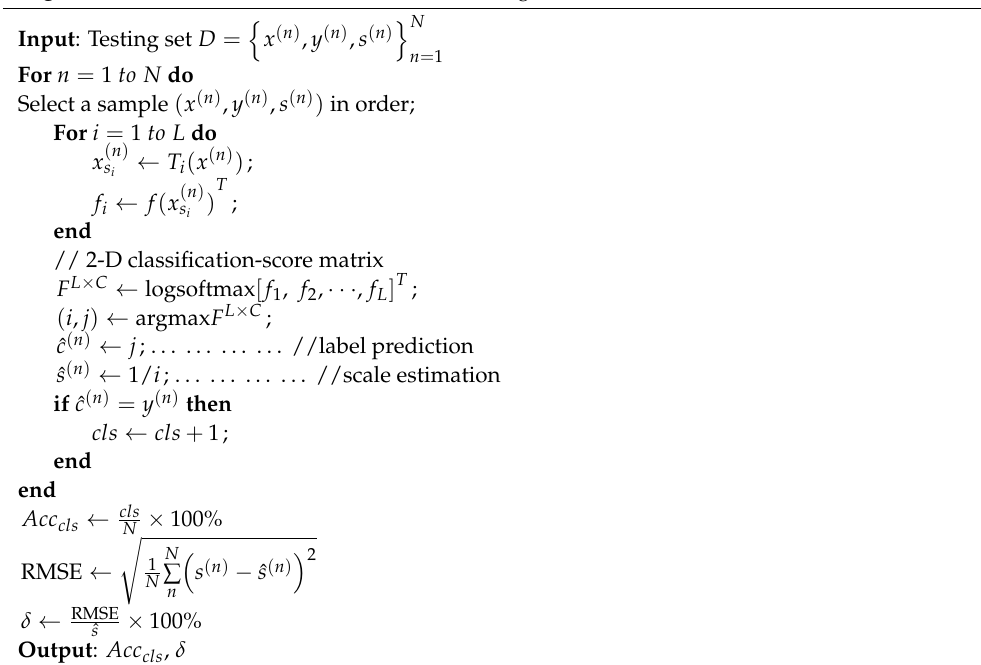
Algorithm 1: Classification and scale estimation algorithm of SA Net